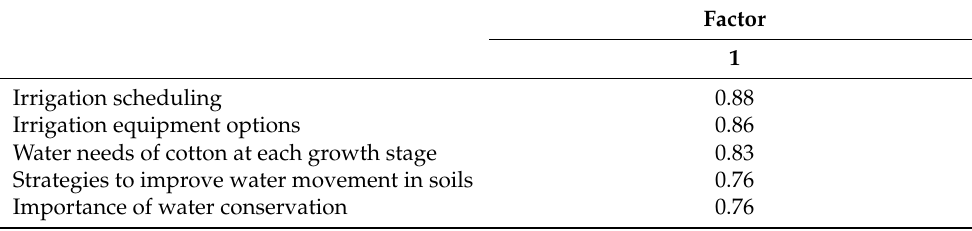
Table 11. Factor loading and proficiency items of water management and conservation